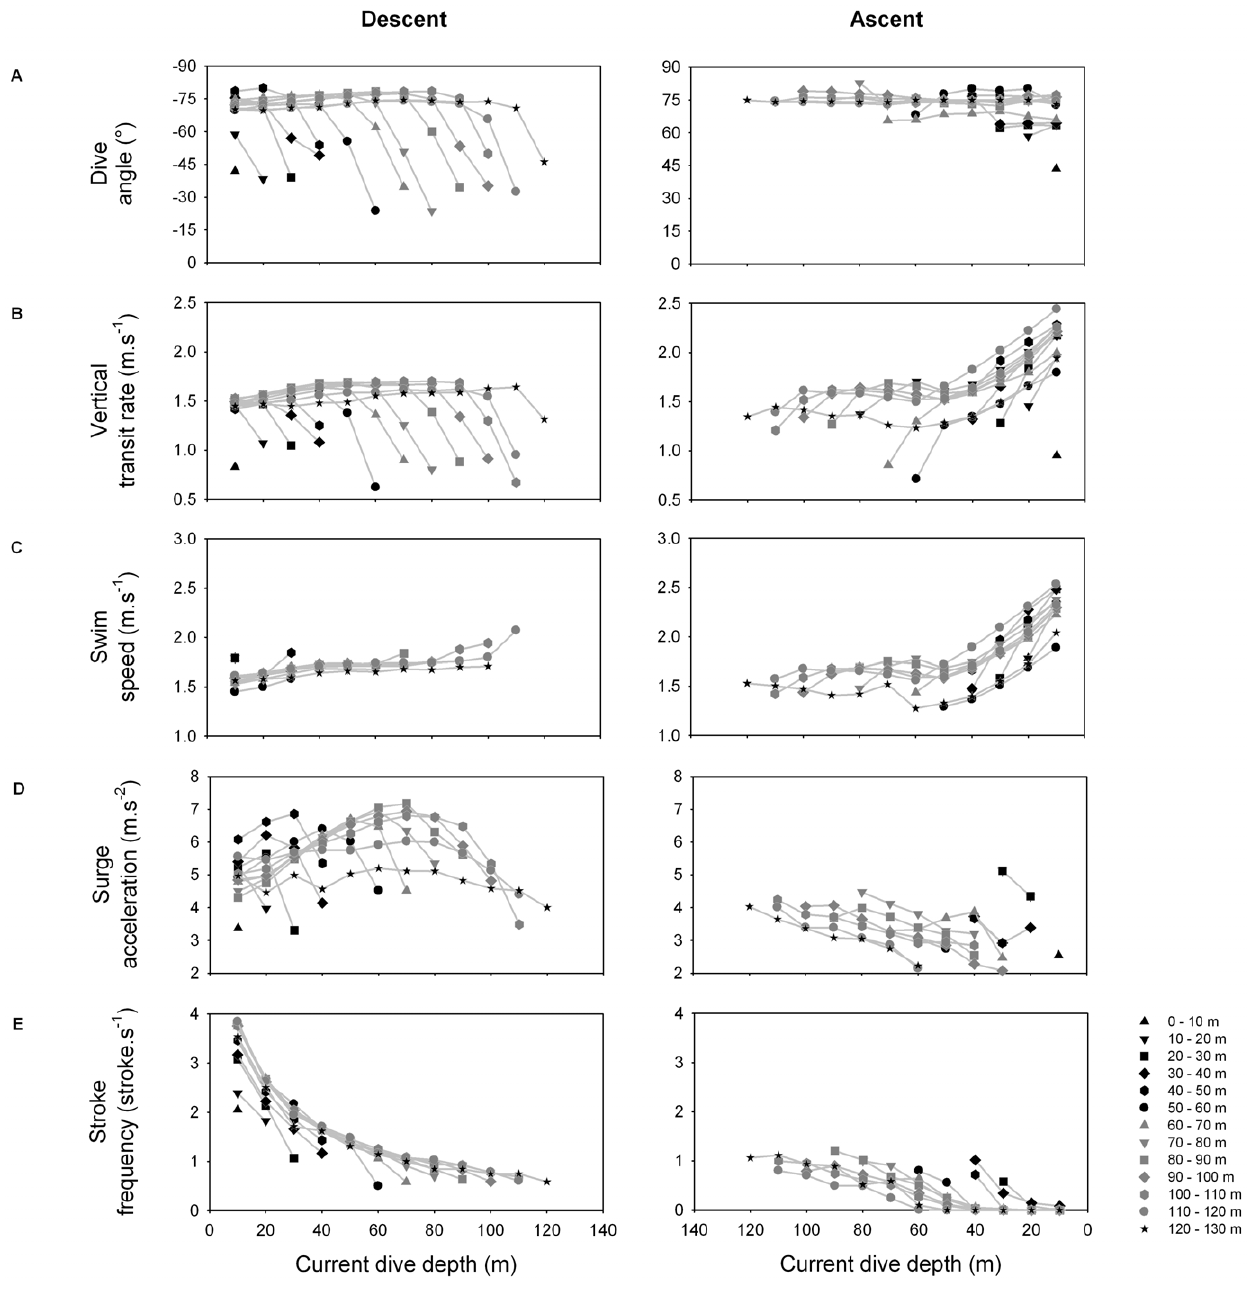
Figure 2. (A) Dive angle, (B) vertical transit rate, (C) swim speed, (D) surge acceleration and (E) foot-stroke frequency, in relation to current dive depth ( . 5 m), for the descent and the ascent phases and for different maximum dive depth categories. Each value was calculated as the mean of individual means. Because stroking activity is so intense during the first 1–2 s of the descent phase (strong and frequent feet kicks), it was not possible to detect the strokes occurring during this period. Consequently, the first current dive depth category (10 m) ranges from 10–15 m, the second (20 m) from 15–25 m, and so on. A maximum dive depth class stood out (120–130 m); for this class, parameters derive from two dives carried out by the same individual.